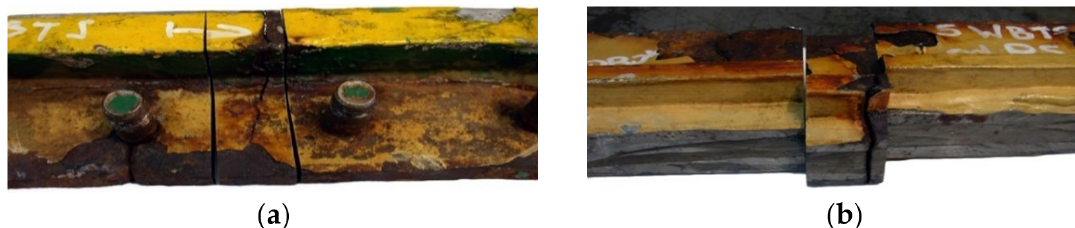
Figure 34. Macroscopic examination (handy-size bulk carrier 30185 DWT): ( a ) lid view of the manhole section marked 5WBTS and ( b ) bottom view of the manhole section marked 5WBTS.